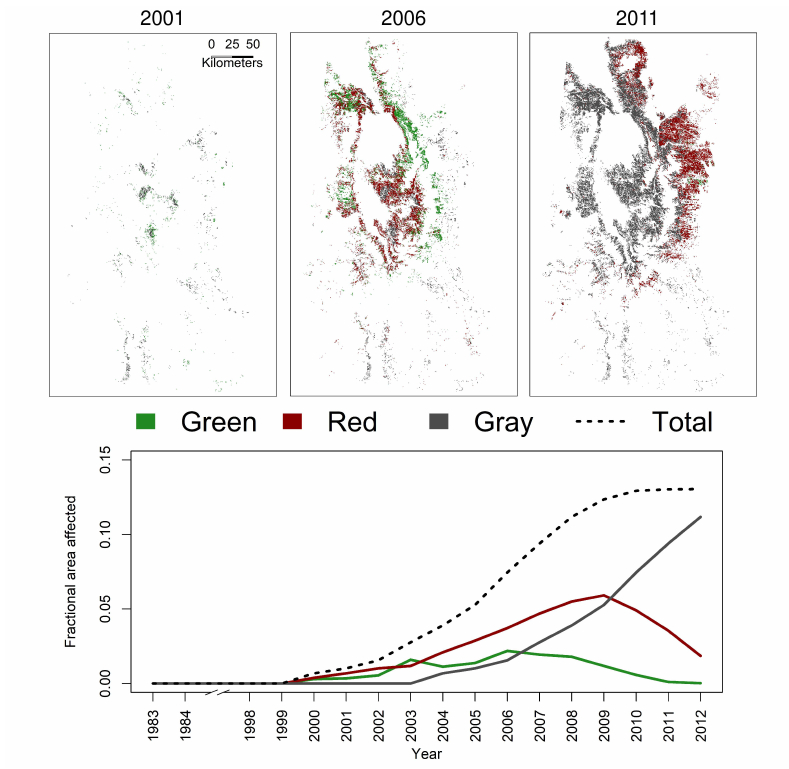
Figure A4. MPB infestation maps in the region of interest for the years 2001, 2006, and 2011 ( top ). This 10-year period depicts the beginning, middle, and peak of the infestations in the study area differentiating the different infestation phases. Temporal evolution of the fraction of the stream network of interest affected by the infestations is shown during the period 1983–2012 ( bottom ). The years between 1984 and 1998 are not depicted since the fraction of area affected is